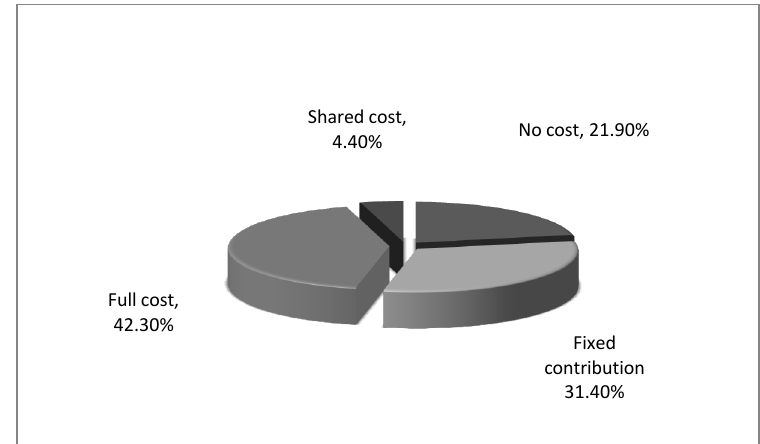
FIGURE 11: Contribution to breakages, 2008 Source: Survey data